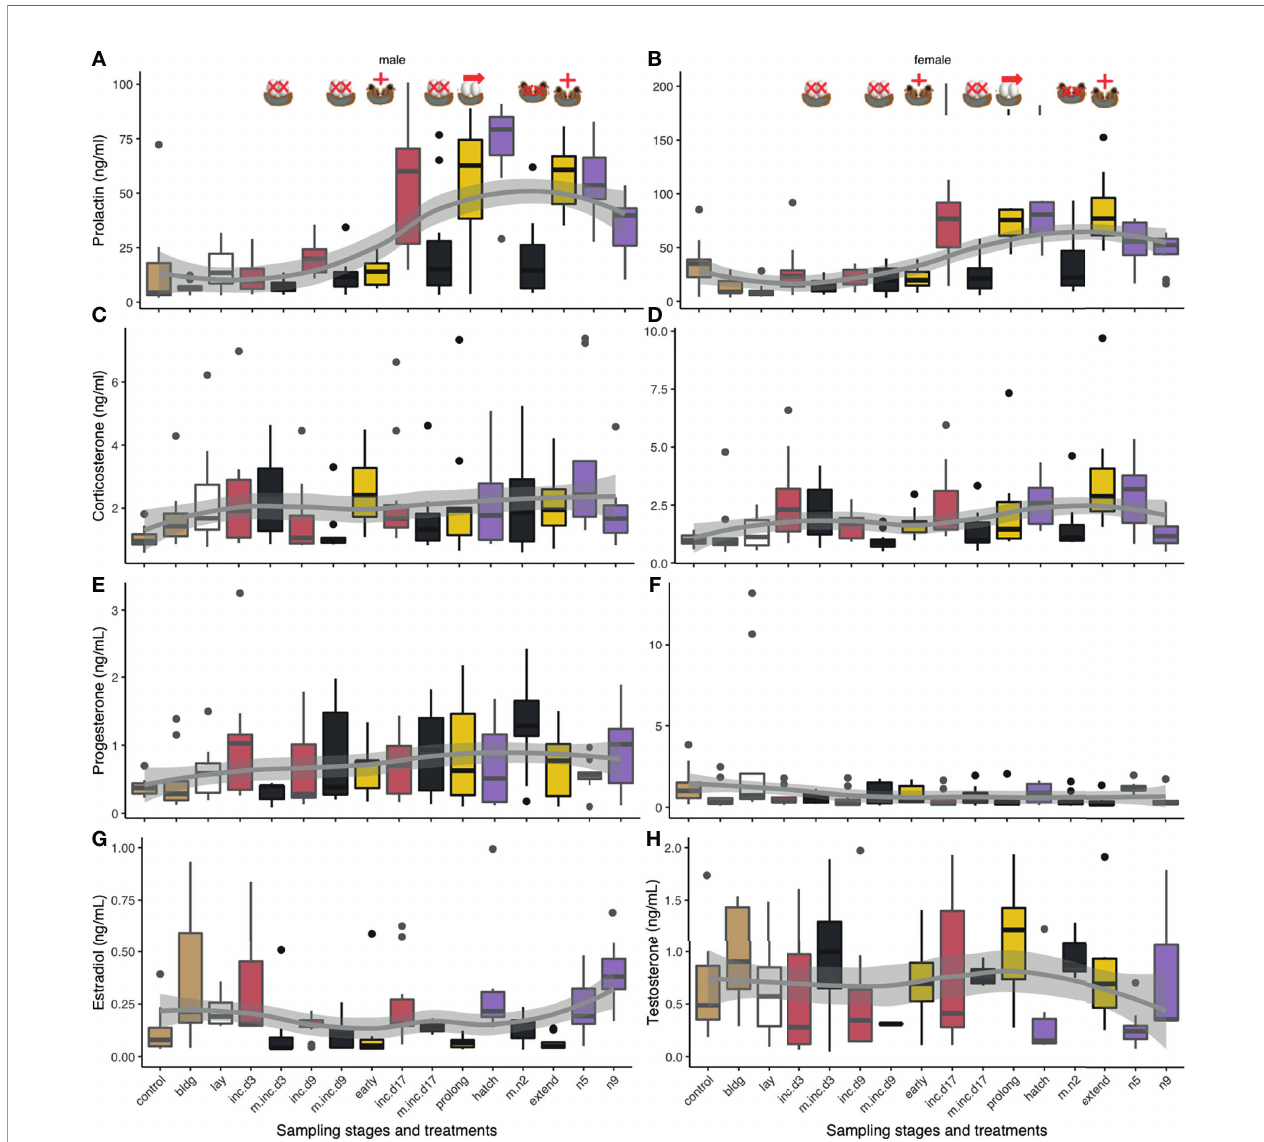
FIGURE 5 | Boxplots of circulating hormone levels (ng/mL) of experimental manipulations (maize yellow) and their pairwise controls (green) for corticosterone (A, B) , progesterone (C, D) , prolactin (E, F) , and the sex steroids [testosterone (G) , estradiol (H) ]. Non-breeding time points are included for reference. Controls (black text) are adjacent to manipulations (blue text) unless there are more than one experimental manipulation for a given time point. Eggs were removed at clutch completion (cc), mid-incubation (mi), and late incubation (li). Chicks were added at mid-incubation and removed at hatch. The incubation period was prolonged by 3 days (prolong) prior to adding chicks for 1d (extend). Box colors indicate different sub-stages periods: non-breeding (control) and nest-building (bldg; brown), laying (lay; white), incubation (red, inc.d3=clutch completion, inc.d9=mid-incubation, and inc.d17=late incubation), and the nestling period (purple; hatch, n5=nestling d5, and n9=nestling d9). Contents for a given manipulation are indicated by the presence of eggs or chicks in the nest and were either removed (black and X), added (yellow; +), or the natural duration of incubation was prolonged (yellow; ! ). Boxes represent median and upper and lower quartiles. Whiskers represent the most extreme data points that are within 1.5 of the interquartile